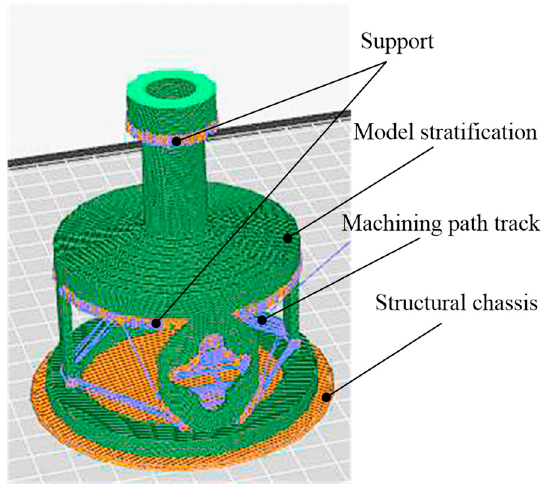
Figure 3. Stratification of the sensor before three-dimensional (3D) printing.